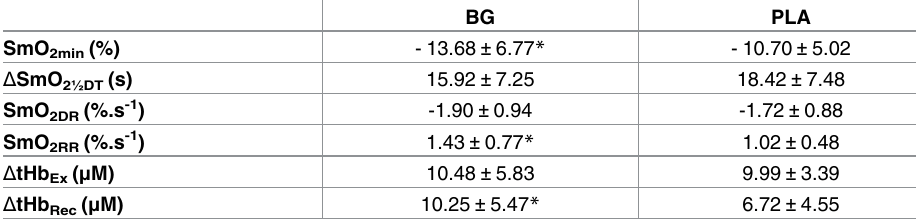
Table 3. Changes in muscle oxygenation and blood volume